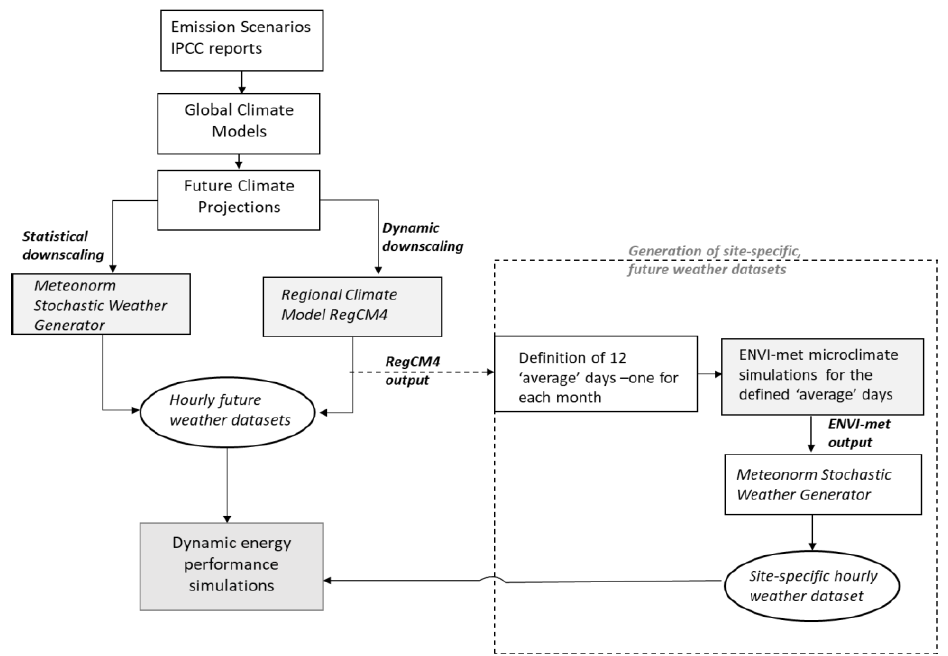
Figure 3. Flowchart of different approaches for preparing climate projection data with fine spatial and temporal resolution.